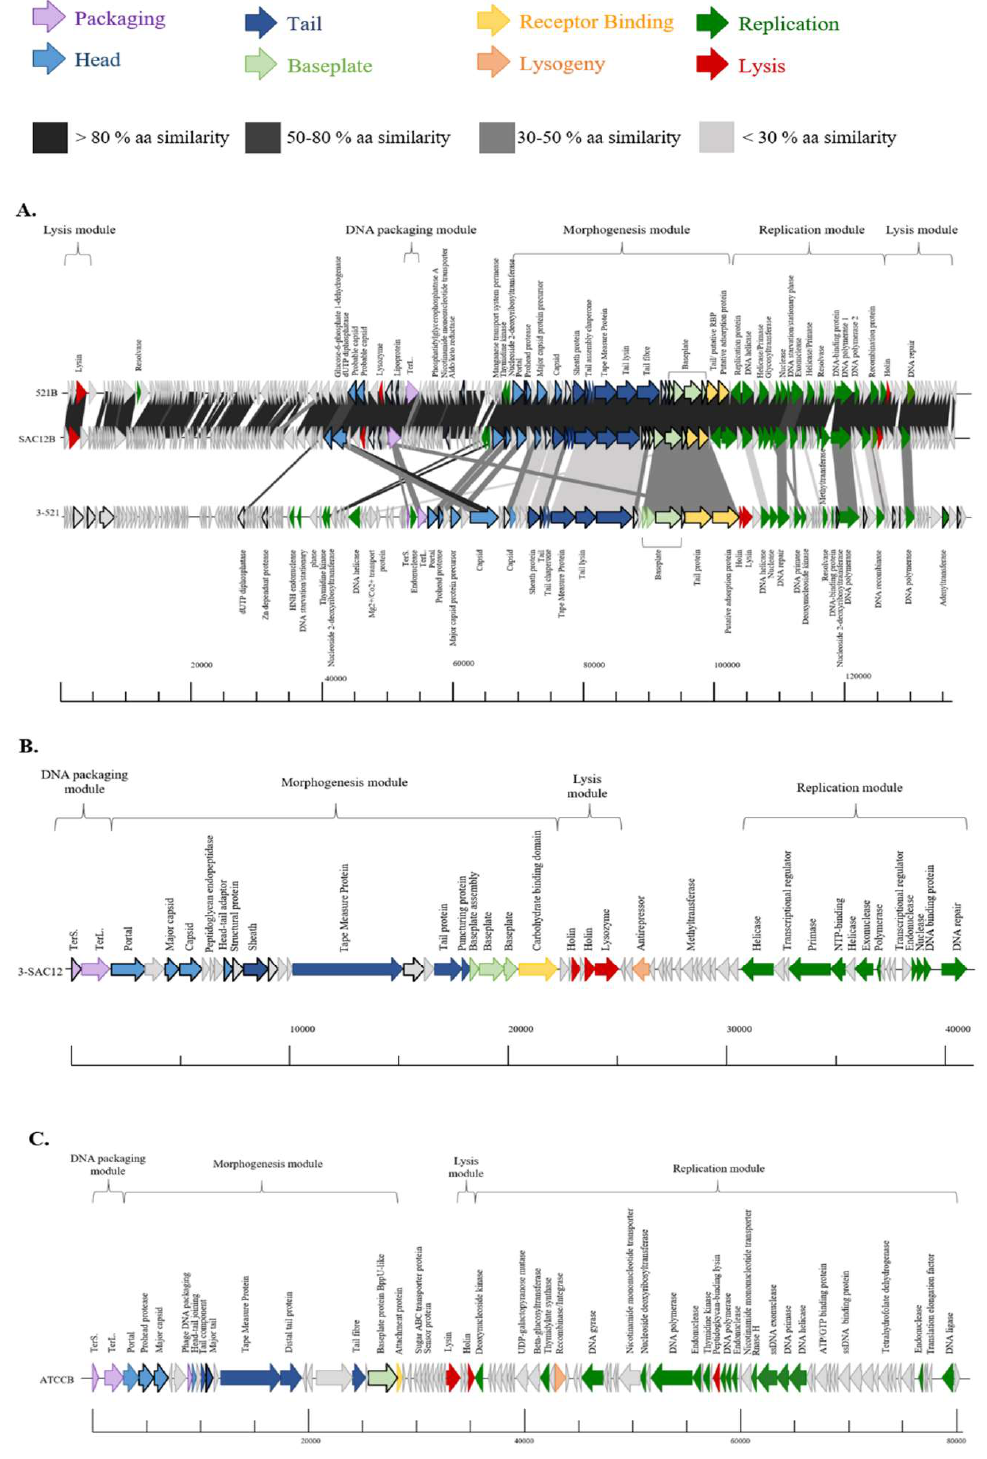
Figure 3. Genomic organisation of lytic Lb. brevis phages 3-521, 521B and SAC12B ( A ), 3-SAC12 ( B ) and ATCCB ( C ). The scale at the bottom of genomes is in base pairs. Each arrow represents an ORF, with the colour representing the putative function of the encoded protein. Confirmed structural protein-encoding genes from mass spectrometry analysis are also highlighted (bold outline). TerS. Small terminase subunit, TerL. Large terminase